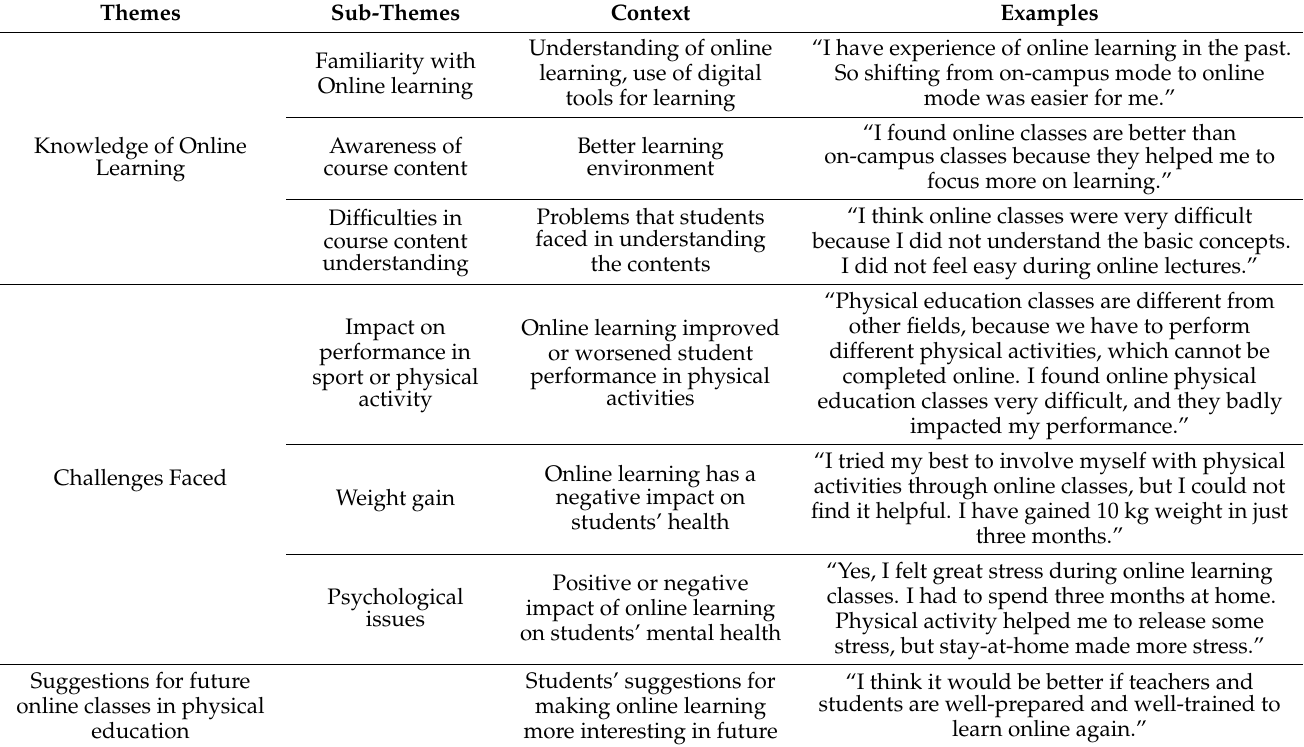
Table 5. Themes and sub-themes derived from focus group